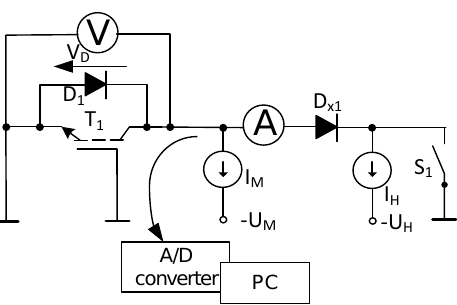
Figure 5. Measurement set-up to determine transient thermal impedance of the diode Z thD (t) included in the investigated device.